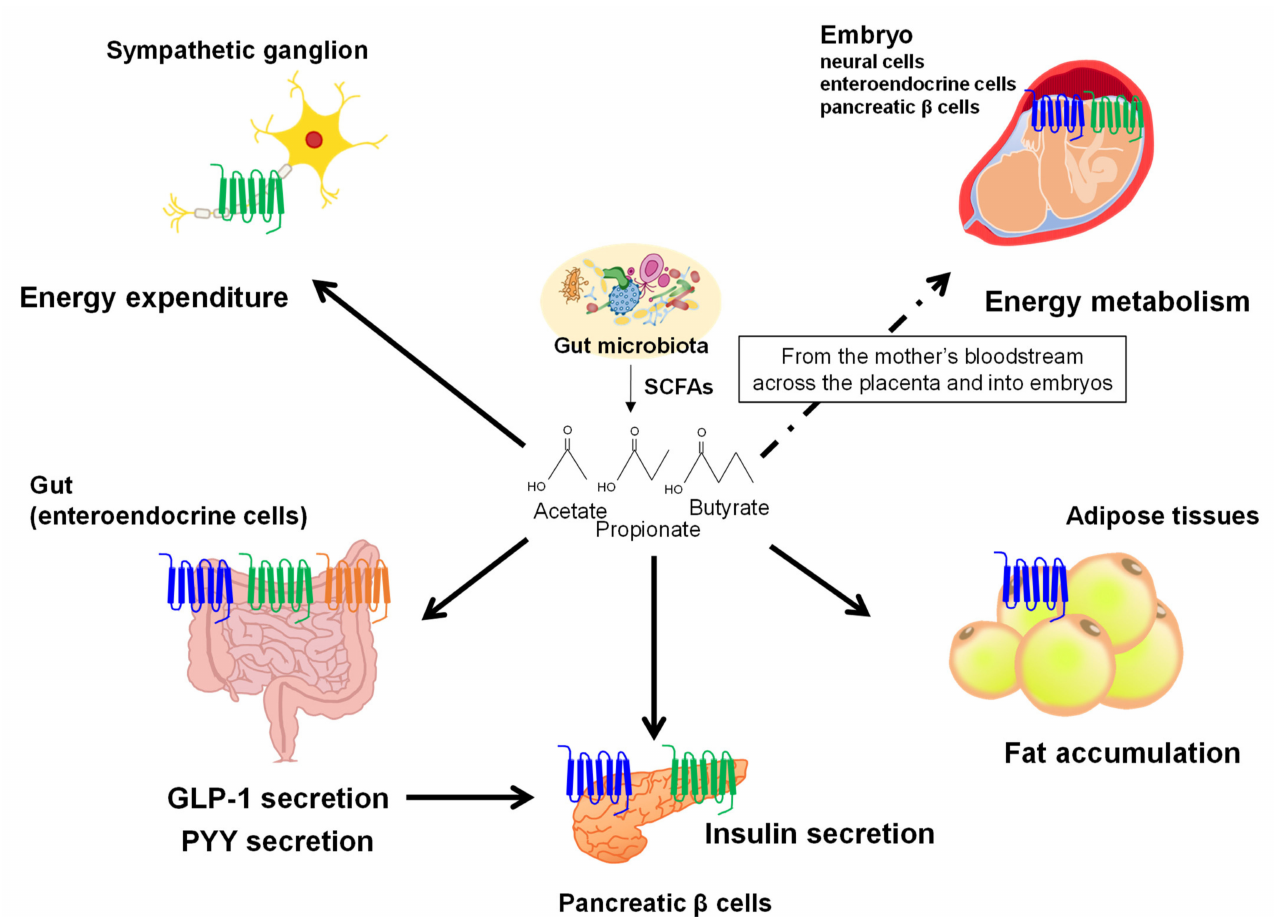
Figure 2. SCFAs, gut microbial metabolites derived from dietary fibers, regulate host energy home- ostasis via